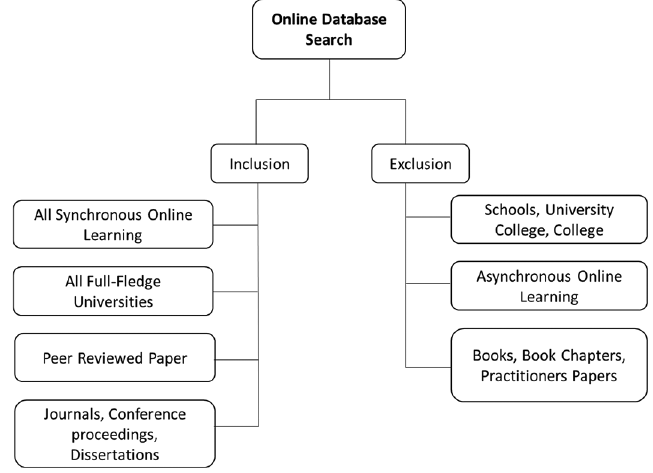
Figure 1. Paper selection process